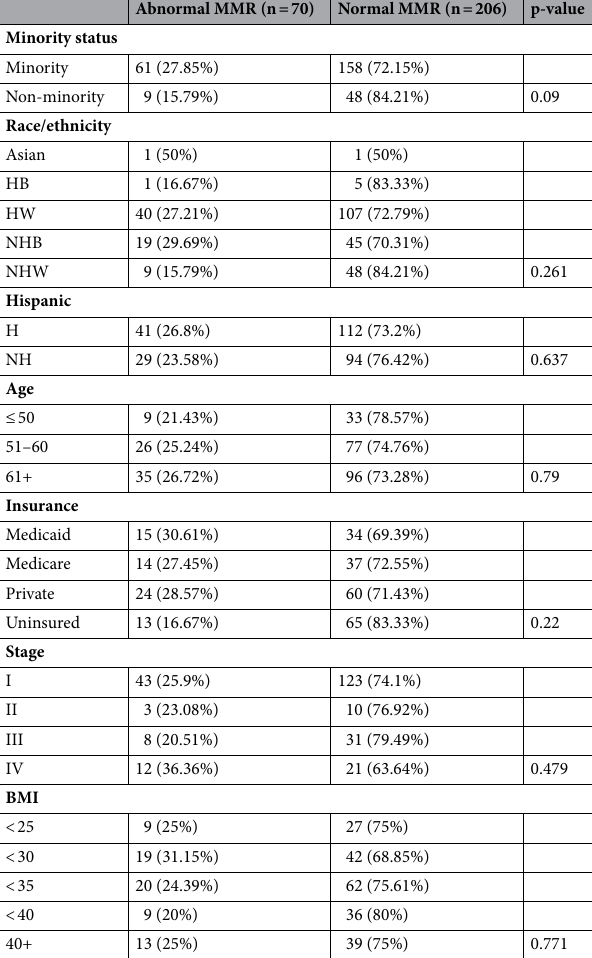
Table 3. Demographic characteristics of patients with normal and abnormal MMR screening. No categories predicted abnormal screening